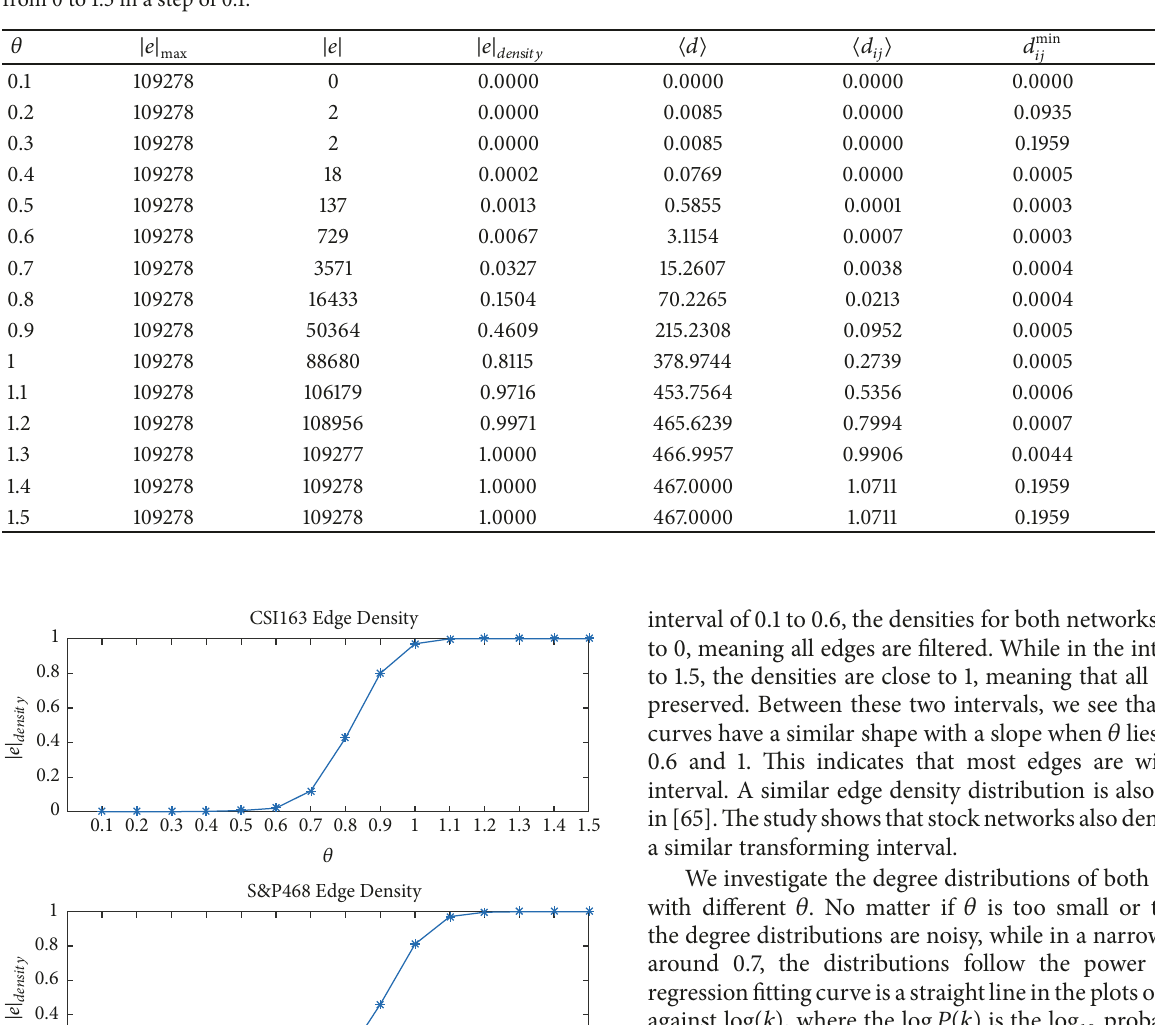
Table 5: For the S&P468 network, the max possible edges |𝑒| max for 𝑁 = 468 vertices, the existing edge number |𝑒| , the edge density |𝑒| 𝑑𝑒𝑛𝑠𝑖𝑡𝑦 , the average degree ⟨𝑑⟩ , the average distance ⟨𝑑 𝑖𝑗 ⟩ , the minimum distance 𝑑 min 𝑖𝑗 , and the maximum distance 𝑑 max 𝑖𝑗 are presented for different 𝜃 from 0 to 1.5 in a step of 0.1.